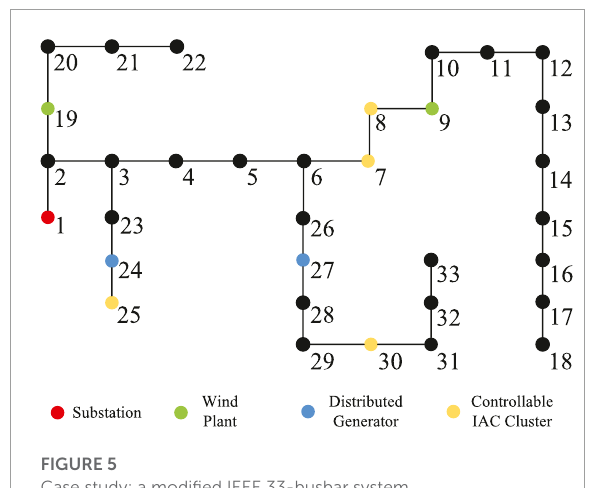
FIGURE 5 Case study: a modified IEEE 33-busbar